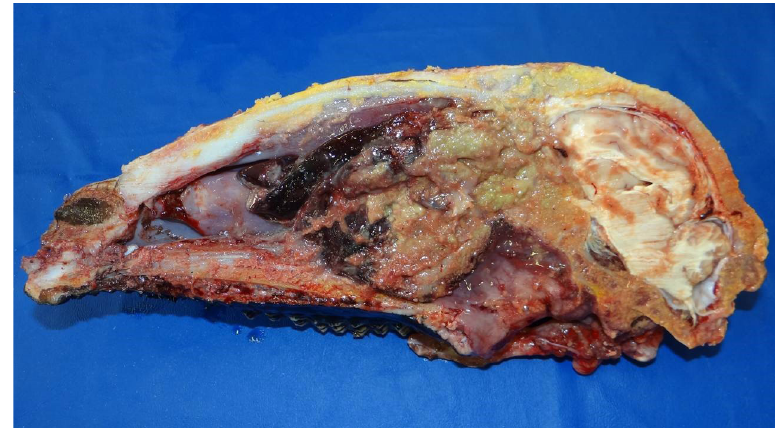
figura 3. Vista medial do antímero direito da cabeça do ovino 2PS com conidiobolomicose nasofaríngea/ rinocerebral evidenciando grande massa branco-amarelada com áreas vermelho enegrecidas de superfície irregular na região etmoidal.